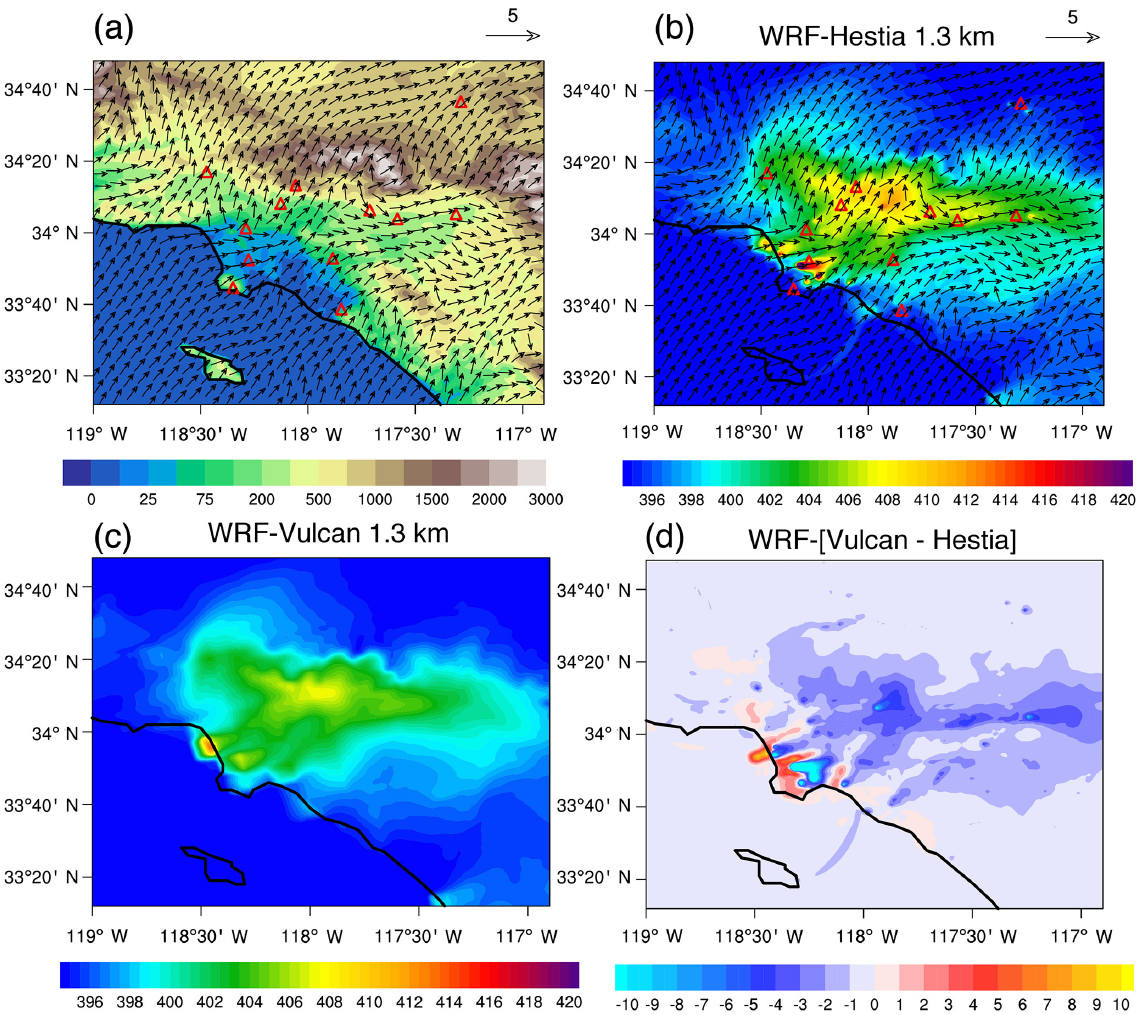
Figure 11. (a, b) The first empirical orthogonal function (EOF 1) for the surface wind pattern (black arrows) simulated by MYNN_UCM_d03 at 14:00PST during CalNex-LA. EOF 1 accounts for 48.1% of the variance in the average winds. Contours: (a) terrain height (unit:m); (b) the modelled surface CO 2 concentration (unit:ppm) from the 1.3km WRF-Hestia run. The red triangles indicate the locations of the GHG measurement sites. (c) The modelled CO 2 concentrations from the 1.3km WRF-Vulcan run (unit:ppm). (d) The difference in the modelled CO 2 concentrations between the 1.3km WRF-Vulcan and WRF-Hestia runs